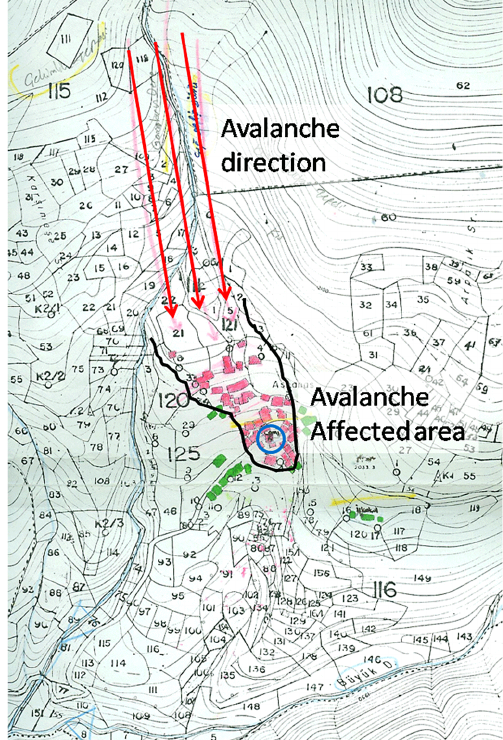
Fig. 9. Avalanche affected houses (red); non-affected houses (green); mosque indicated by blue circle, see Fig. 4 (Source: